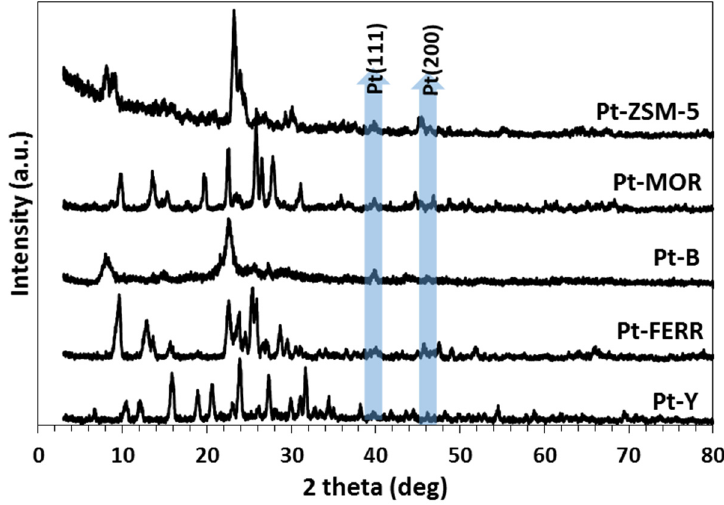
Figure 1. XRD patterns of the Pt-incorporated different zeolite materials.